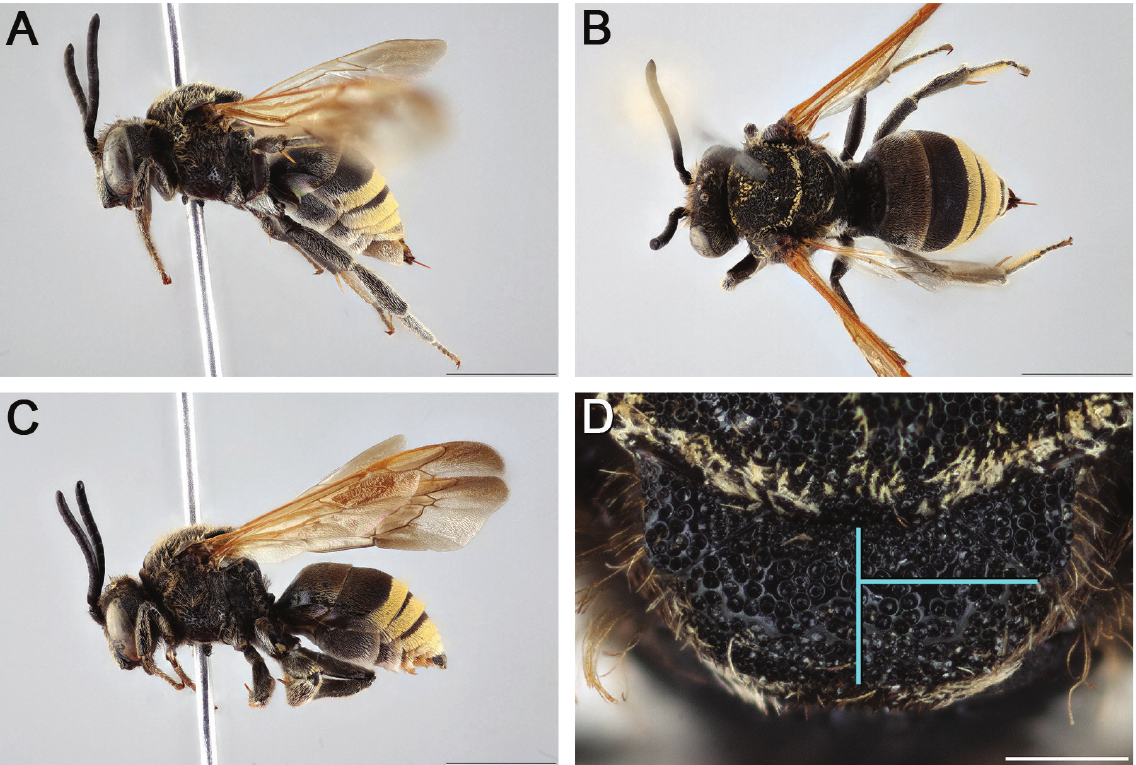
Fig. 18. Epeolus odyneroides sp. nov. A – B , D . Holotype, ♀ (KUNHM SM0253729). C . Allotype, ♂ (KUNHM SM0255860). A . Habitus, lateral view. B . Habitus, dorsal view. C . Habitus, lateral view. D . Axillae and mesoscutellum, dorsal view (blue lines indicate the posterior extent of the axilla relative to the length of the mesoscutellum). Scale bars: A–C = 3 mm; D = 0.5